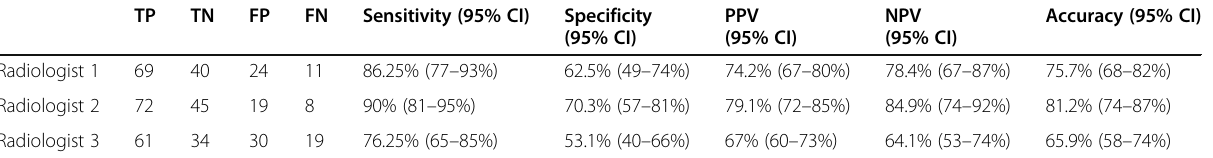
Table 5 Performance results of the three radiologists for differentiation between COVID-19- and non-COVID-19-associated GGO after exclusion of viral